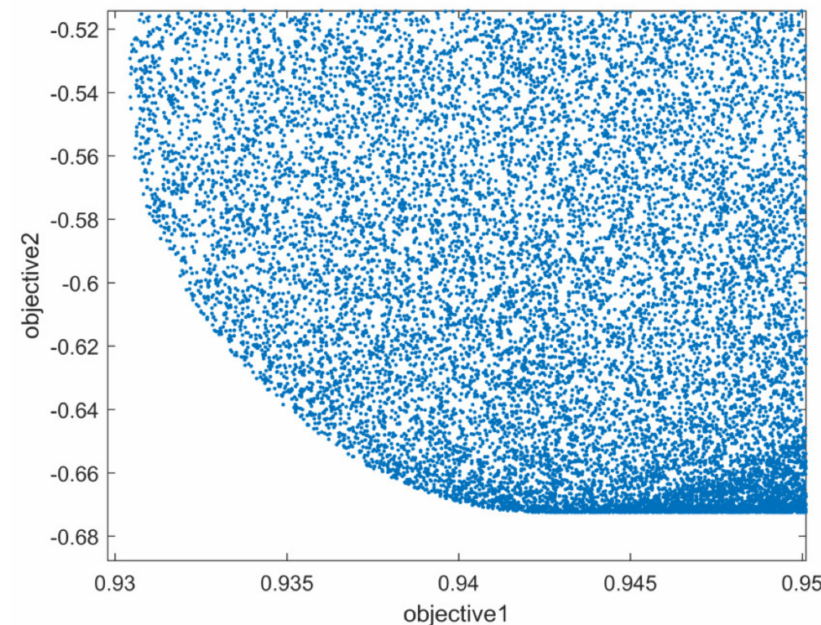
Figure 6. The section of Figure 5 where the Pareto front is located.